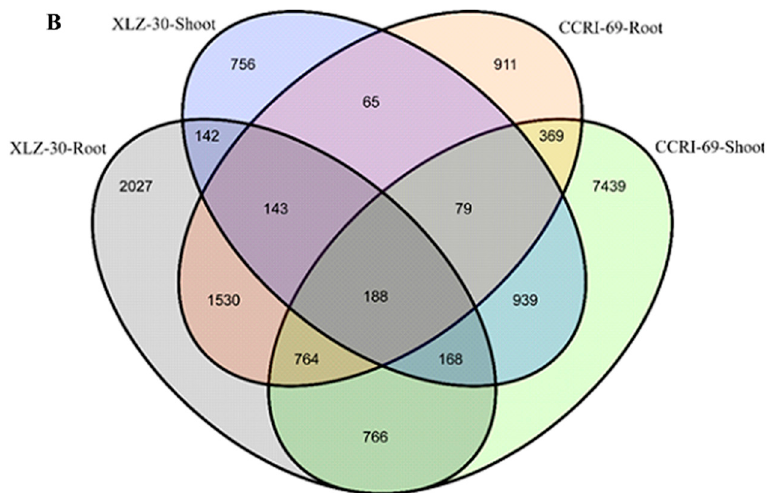
Figure 1. Differentially expressed genes (DEGs) of cotton genotypes at given time points during the nitrogen resupply treatments. ( A ) Number of DEGs identified by pairwise comparisons between nitrogen starvation and resupply treatments. Upregulated (black) and downregulated (red) genes were quantified. Based on DESeq software, genes with p -value < 0.05 were considered as significantly differential expression, and a 2-fold variance was used to identify the genes differentially expressed between the two libraries. ( B ) Venn map of DEGs among different combinations of comparisons at given time points. XLZ-30-Roots (0 h vs. 6 h), XLZ-30-Shoot (0 h vs. 6 h), CCRI-69-Root (0 h vs. 6 h), and CCRI-69-Shoot (0 h vs. 6 h) indicate cotton genotypes resupplied with nitrogen being treated with nitrogen free solution for 5 days.